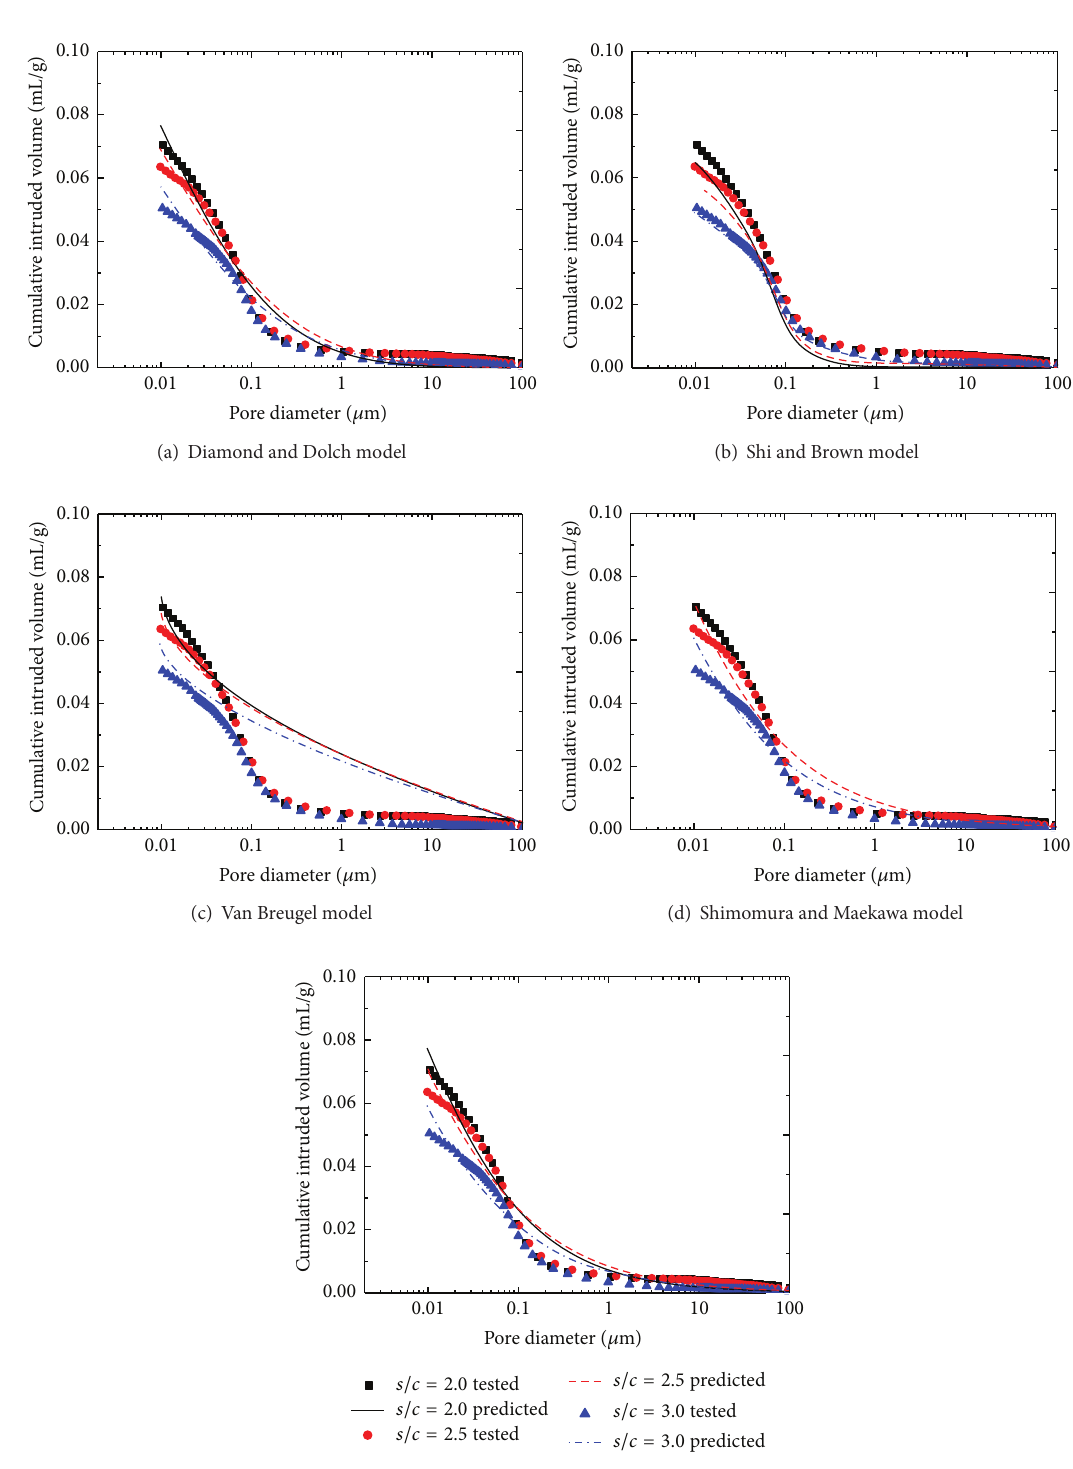
Figure 6: Comparison between test and predicted results by existing models for manufactured sand